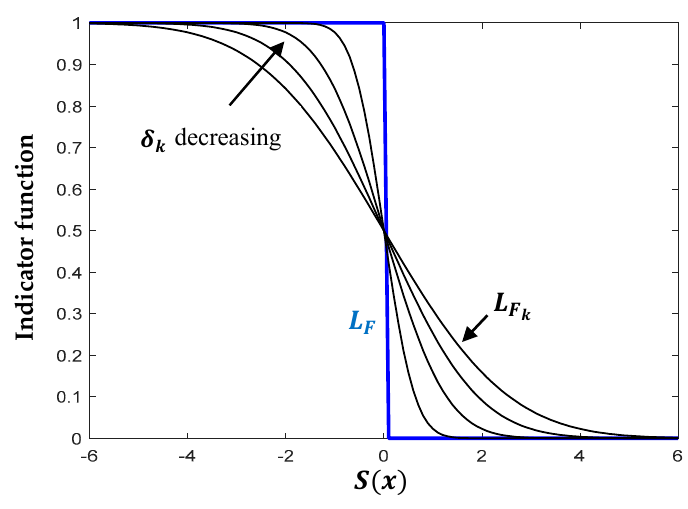
Figure 3. Indicator function approximation.